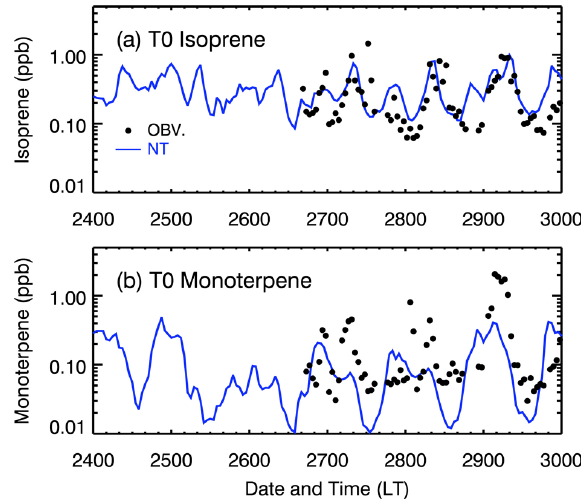
Figure 7 Fig. 7. Same as Fig. 6, except for (a) isoprene and (b)